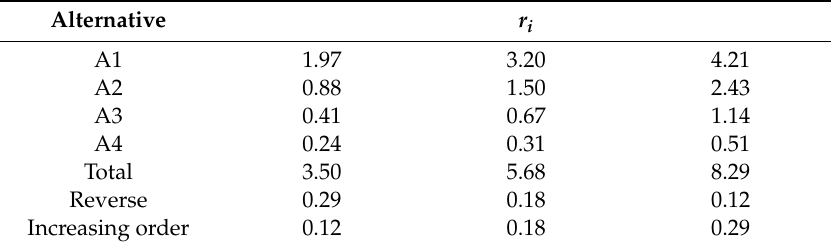
Table 6. Geometric means of alternatives in respect of implementation